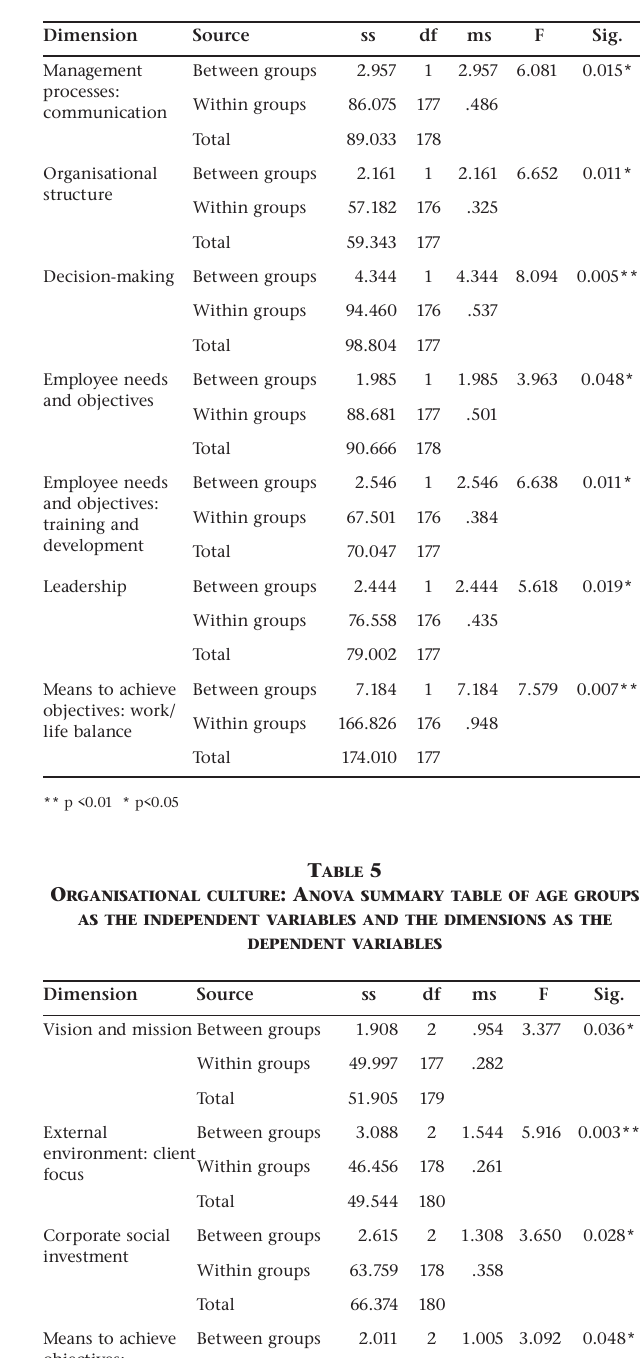
T able 3 o rganisaTional culTure : a nova summary Table for The job levels as The independenT variables and The dimensions as The dependenT variables